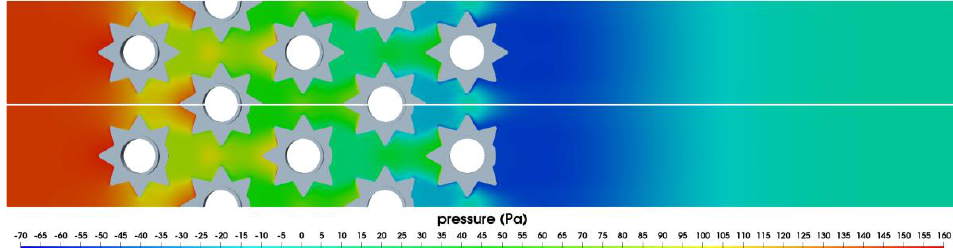
Figure 9. Pressure - drop fields for star-shaped fins and trimmed fins.